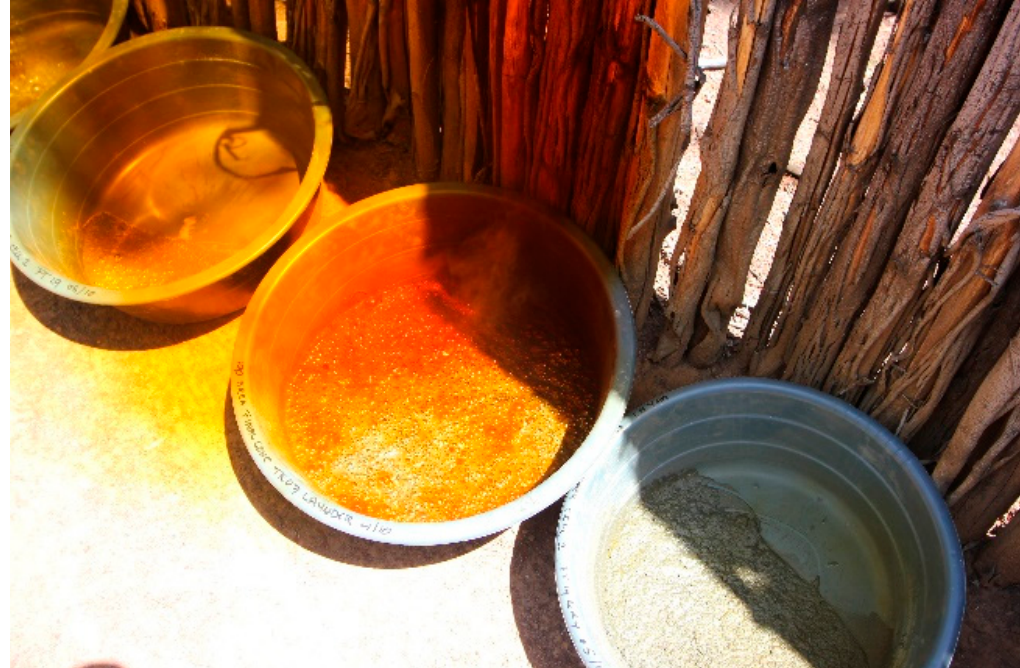
Figure 8. Nitric acid wash: photograph of the reaction of the nitric acid with materials containing abundant sulphides and silicates. Using this nitric acid wash for the illegal upgrading of concentrates is an unsafe practice. Although we applied the same method to replicate the results of this process, the informant was issued with appropriate personal protective equipment.